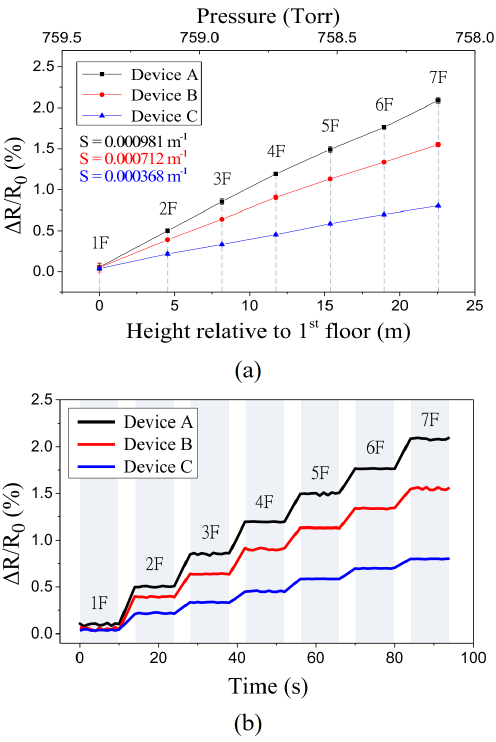
Figure 10. ( a ) Resistance changes in response to the variation in the floor elevation. ( b ) Transient response of the sensor when moving with an elevator from the 1st floor to the 7th floor.